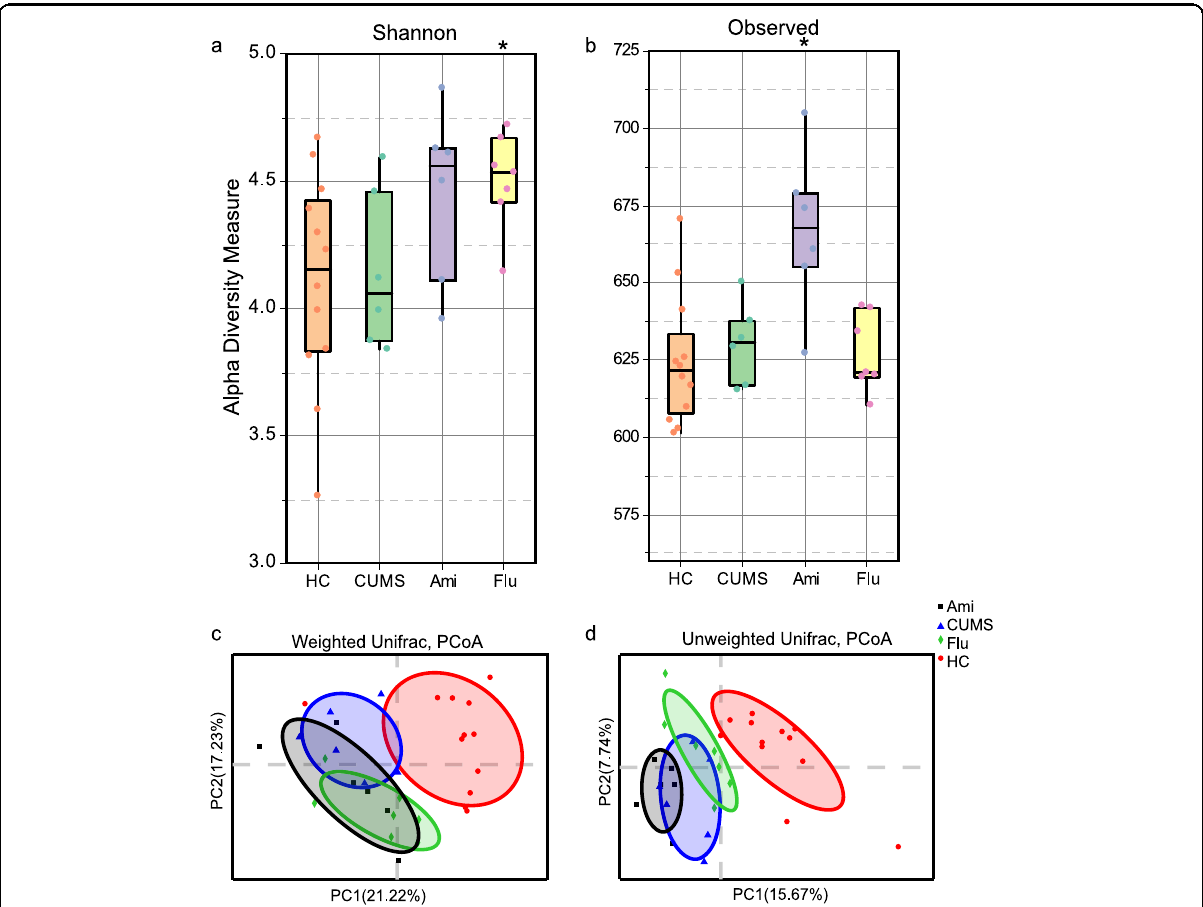
Fig. 2 Measures of bacterial alpha- and beta-diversity. a ‘ Shannon ’ diversity considers both richness and evenness of OTUs within a sample. b ‘ Observed ’ diversity represents the number of OTUs (richness) present in each sample. c PCoA plots of bacterial beta-diversity based on weighted UniFrac distances at week 15. d PCoA plots of bacterial beta-diversity based on unweighted UniFrac distances at week 15. Kruskal – Wallis H followed by Tukey ’ s posthoc test performed to evaluate statistical signi fi cance. * P < 0.05 vs.